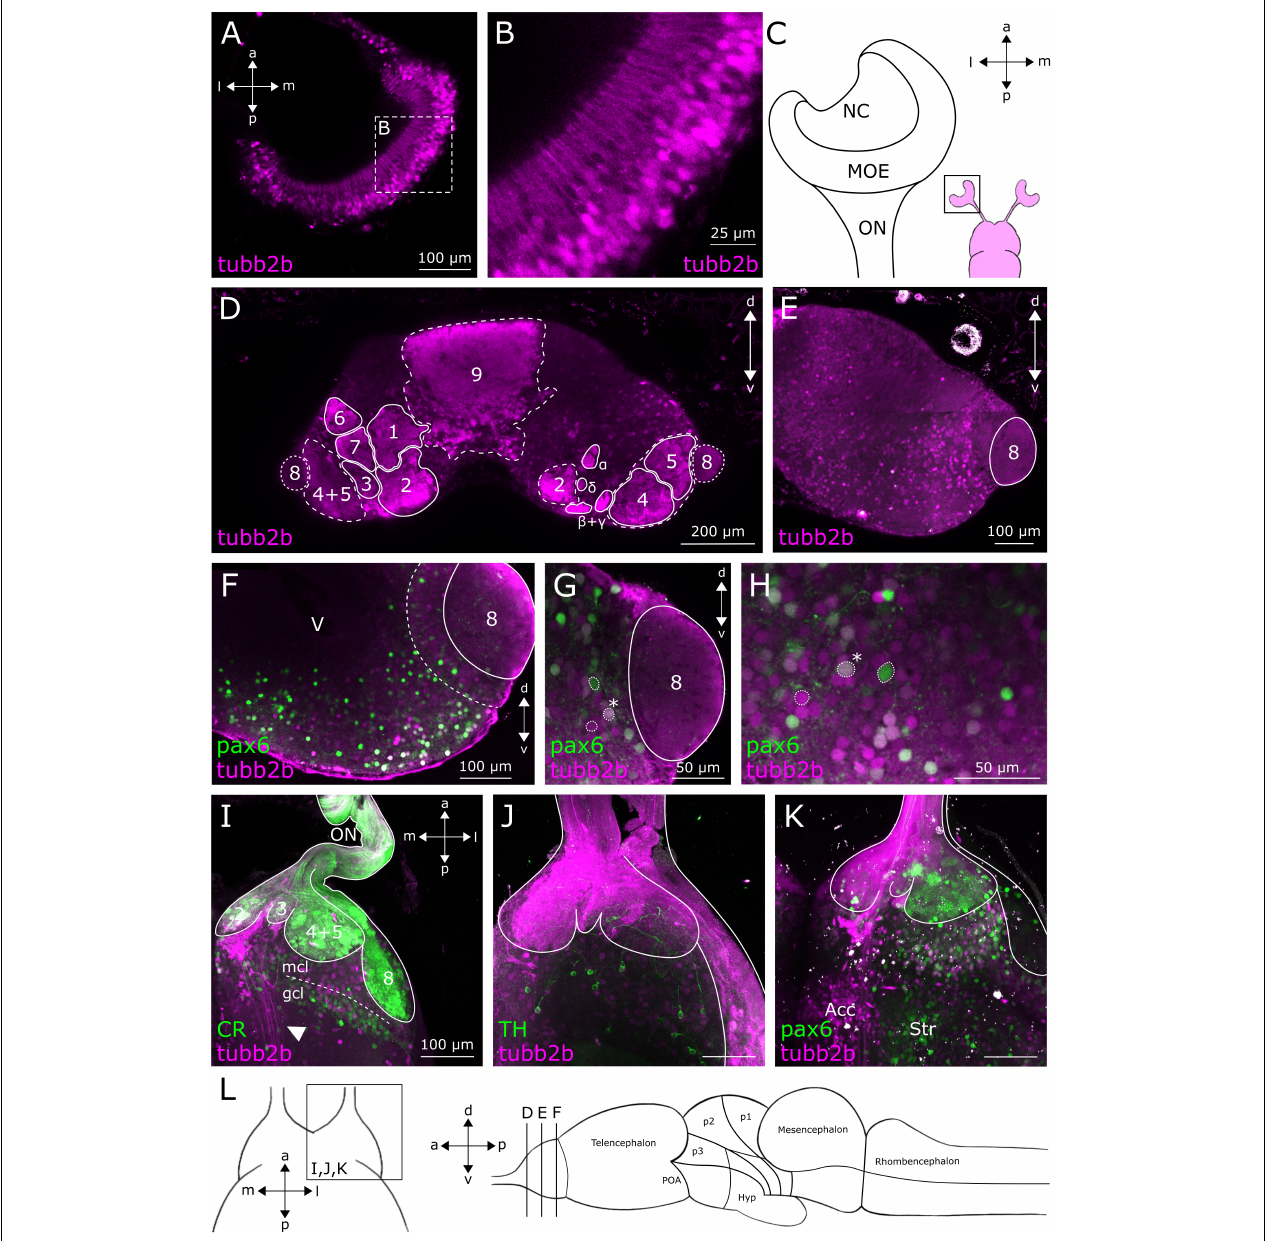
FIGURE 1 | tubb2b -dependent fluorescence within the MOE and OB of larval Xenopus laevis . (A) Dorsal view of a single focal plane of the left main olfactory epithelium (MOE). tubb2b -dependent fluorescence (magenta) is present in olfactory receptor neurons. (B) Close-up of tubb2b -positive olfactory receptor neurons of the MOE. (C) Schematic overview of the olfactory organs (magenta). Close-up of the left MOE. (D) Coronal slice of the OB (left and right) of a transgenic NBT-Katushka γ -cry-Venus tadpole. tubb2b -dependent fluorescence (magenta) is present in axons of ORNs terminating in all known axonal projection fields of the OB (projection fields 1–9 and projection fields α , β , γ , and δ ; see Gaudin and Gascuel, 2005). (E) Coronal slice of the OB (one side only) of transgenic NBT-Katushka γ -cry-Venus tadpoles and tubb2b -dependent fluorescence in cells of the mitral cell layer of the main and accessory (projection field 8) olfactory bulb. (F–H) Coronal slices of the OB (one side only) of transgenic NBT-Katushka pax6-GFP tadpoles. (F) tubb2b - (magenta) and pax6 -dependent fluorescence (green) in cells in the mitral cell layer. (G,H) Close-ups of the mitral cell layer of the main and accessory OB showing tubb2b -dependent fluorescence and pax6 -dependent fluorescence. Examples of cells featuring tubb2b -dependent fluorescence only and pax6 -dependent fluorescence only, and double-fluorescent cells ( ∗ ) are encircled. (I–K) Maximum projection of the whole ventral OB of one brain hemisphere. (I) tubb2b -dependent fluorescence has not been detected in calretinin (CR; green)-positive cells. tubb2b -positive fibers that bypass the OB were found in the intermediate OB (white arrow). (J) tubb2b -dependent fluorescence has not been detected in tyrosine hydroxylase (TH; green)-positive cells. (K) tubb2b -dependent fluorescence and pax6 -dependent fluorescence have been detected in cells of the mitral cell layer. tubb2b -dependent fluorescence was also found in the nucleus accumbens (Acc) and pax6 -dependent fluorescence in the anterior part of the striatum (Str). (L) Scheme of the larval brain showing the approximate positions (lines) of the sections shown in (A–L) . POA, preoptic area; Hyp, hypothalamus; NC, nasal cavity; ON, olfactory nerve; mcl, mitral cell layer; gcl, granule cell layer; V, ventricle; d, dorsal; v, ventral; a, anterior; p, posterior; m, medial; l,